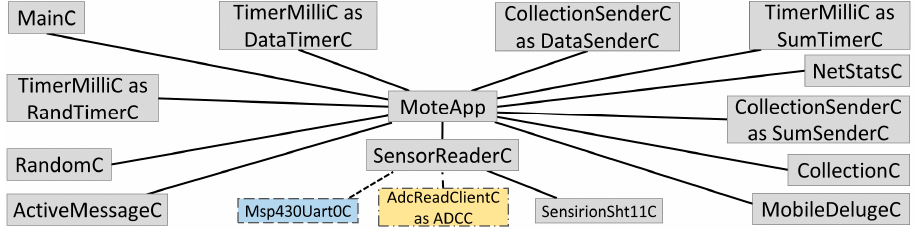
Figure 4. Mote application architecture.